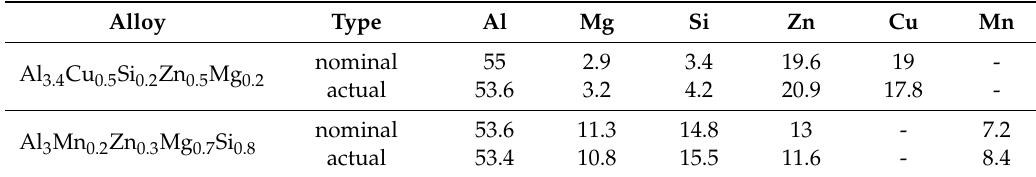
Figure 11. Precipitation kinetics in Al 3 Mn 0.2 Zn 0.3 Mg 0.7 Si 0.8 alloy during annealing at 400 ◦ C, for 2 h: ( a ) heat treatment diagram, ( b ) precipitate phase fraction versus time, ( c ) precipitate number density versus time, ( d ) precipitate mean radius versus time. Table 4. Alloys chemical composition in weight percent.